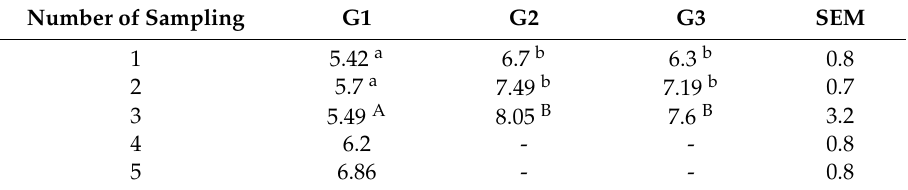
Table 3. Changes in protein (%) content in sheep’s milk from the Group 1 (lambing in February–milked from April to August, Group 2 (lambing in June–milked from August to October), Group 3 (lambing in June–milked from August to November and melatonin-treated before 6 weeks parturition). Number of Sampling